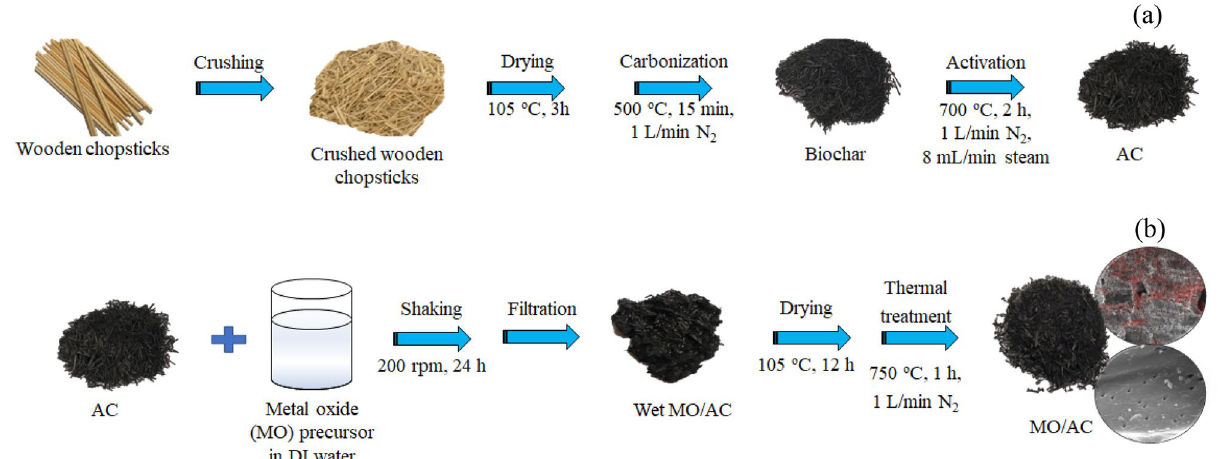
Figure 1. Synthesis procedure of ( a ) AC and ( b ) MO/AC in this